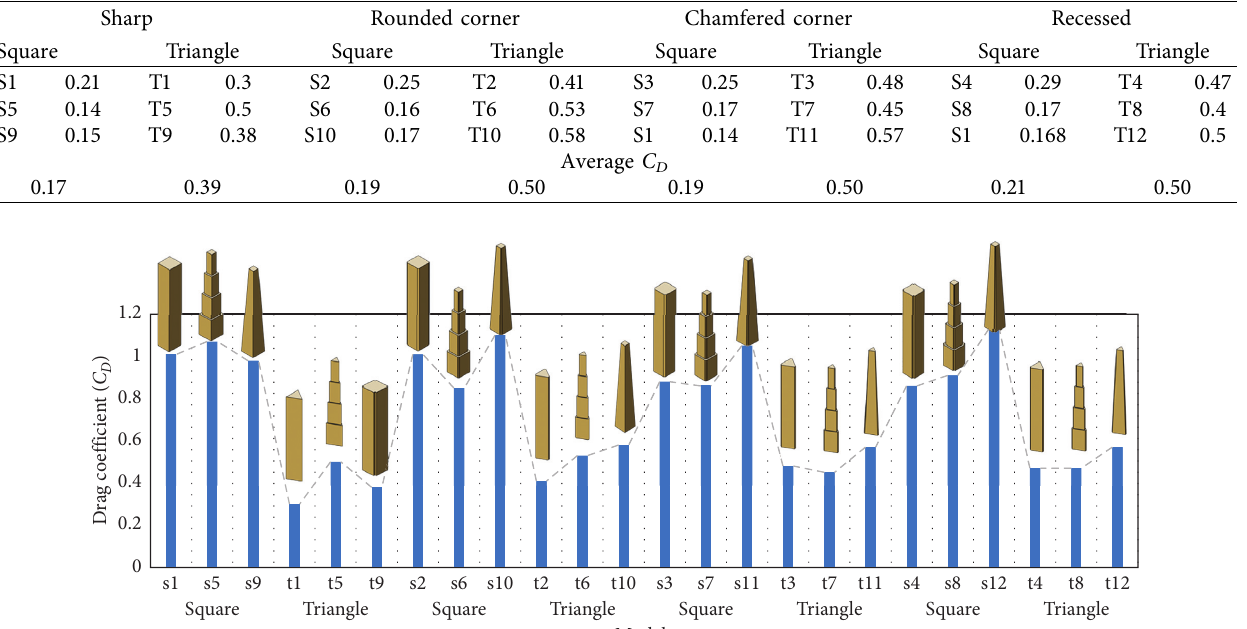
Figure 7: Comparison of the aerodynamic forms in relation to C Table 3: Comparison of the aerodynamic modifications in relation to C